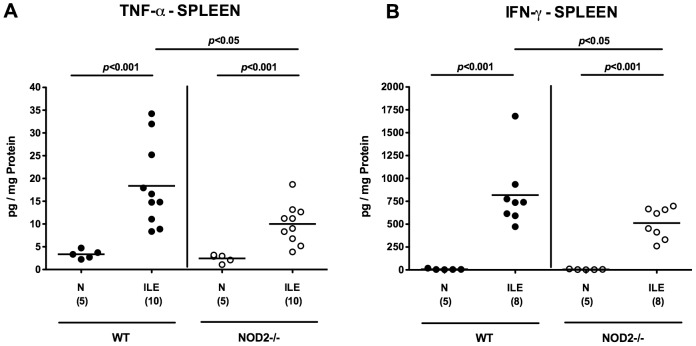
Pro-inflammatory cytokine responses in spleens of NOD2 deficient mice following ileitis induction.Systemic pro-inflammatory cytokine responses were assessed by measuring (A) TNF-α and (B) IFN-γ levels in ex vivo biopsies of spleens derived from C57BL/6 wildtype (WT; black circles) and NOD2 deficient (NOD2-/-; white circles) mice seven days following ileitis induction (ILE). Naive mice served as negative controls (N). Numbers of analyzed mice (in parentheses), means (black bars) and levels of significance (P-values) as compared to the respective groups (determined by Mann-Whitney-U test) are indicated. Data shown are representative for three independent experiments.